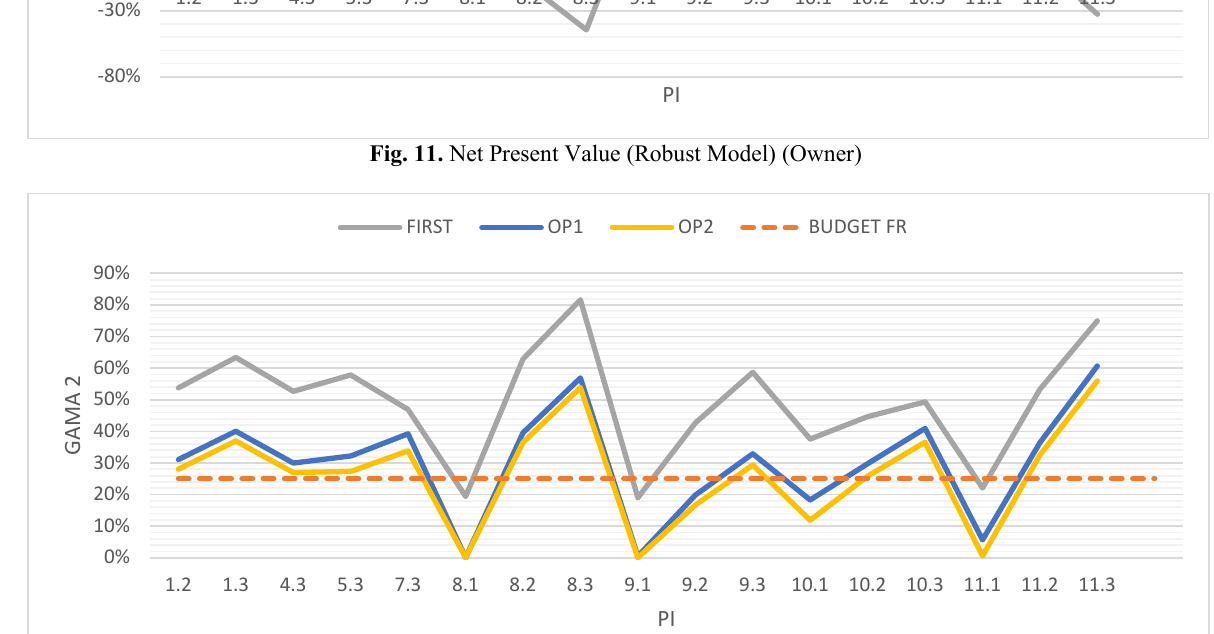
Fig. 12. Financial Risk (Robust Model)